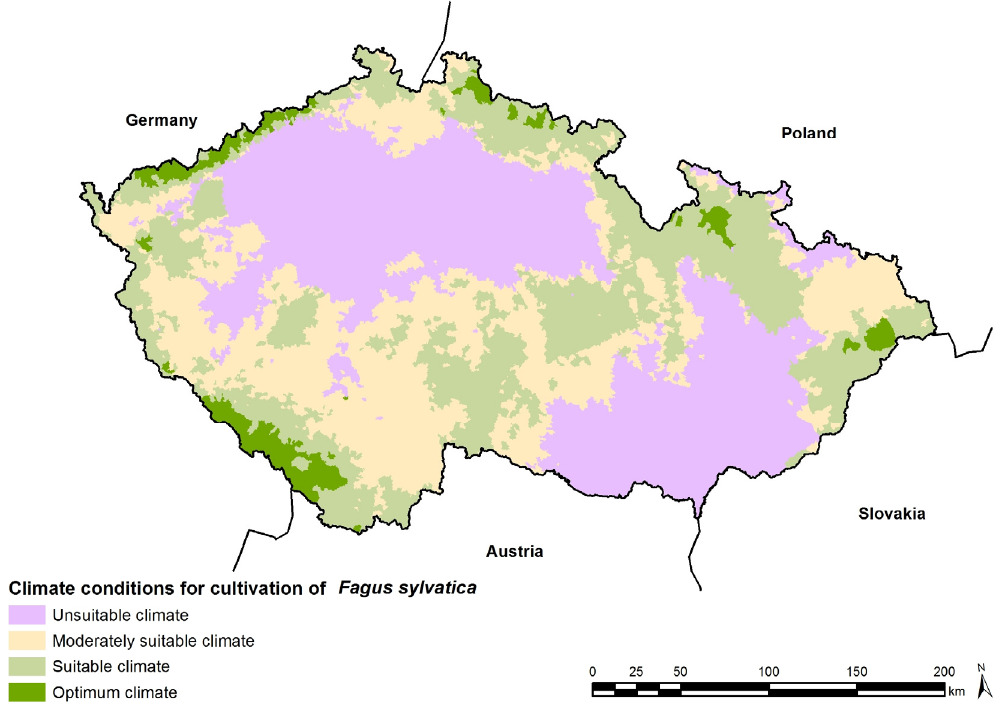
Figure 5. Visualization of predicted distribution of climate conditions for the European beech in the Czech Republic in 2070.